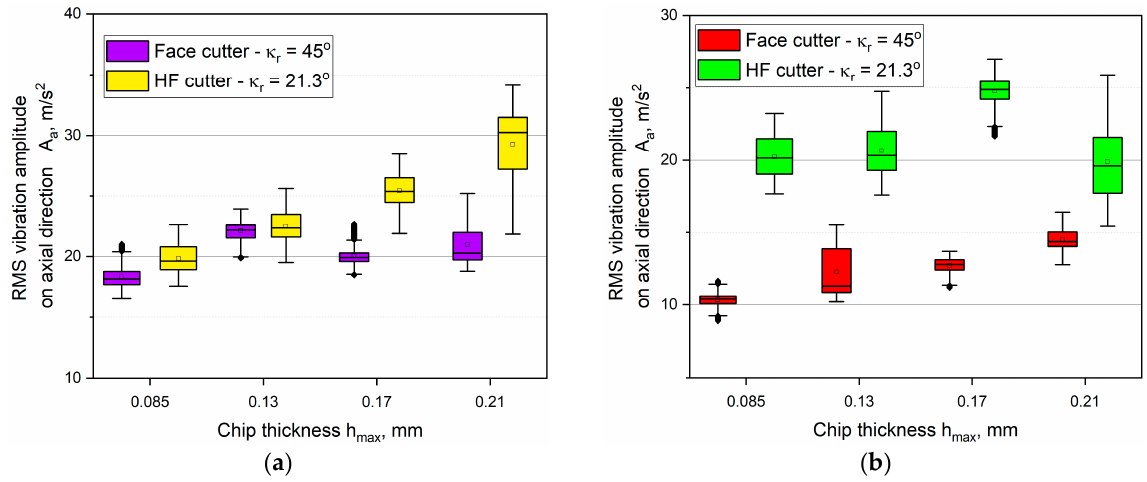
Figure 11. The influence of the chip thickness on the vibration amplitude values in the axial direction A a : ( a ) up milling, ( b ) down milling.